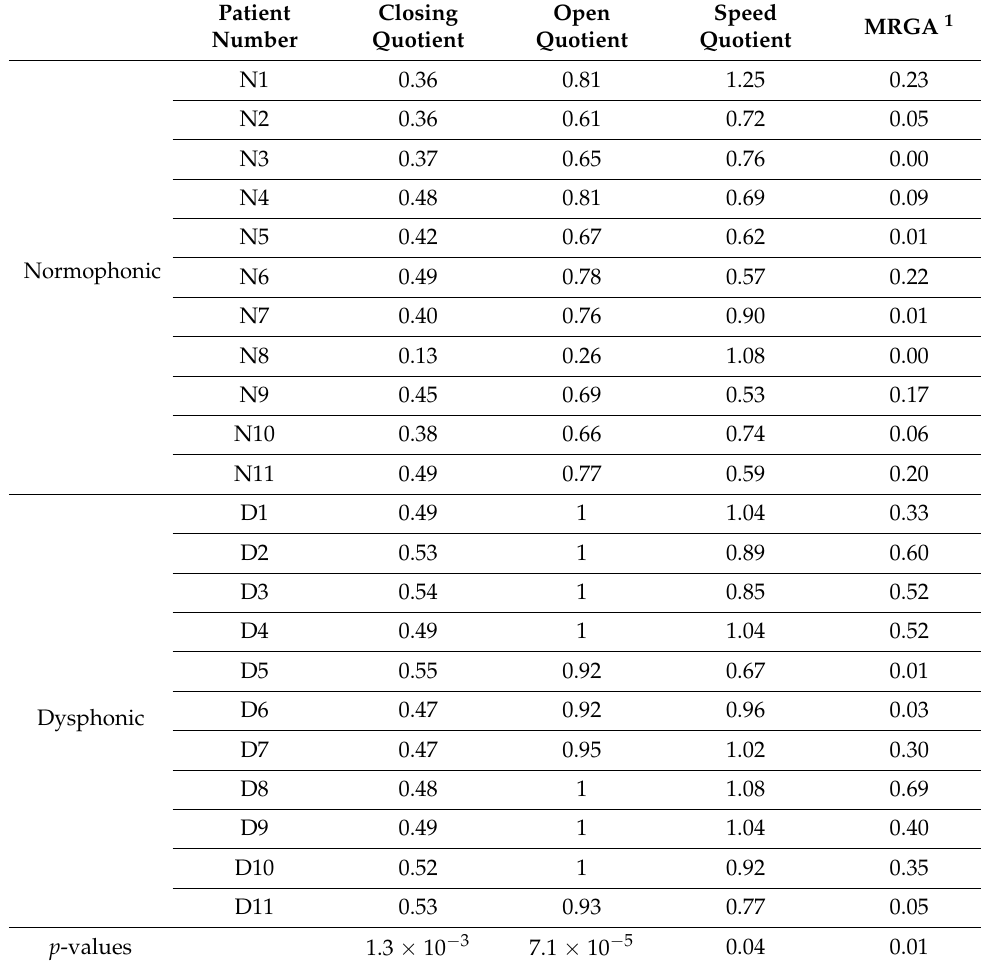
Table 2. Geometric and time-related parameters for the segmented LHSV images in normophonic subjects and dysphonic subjects with glottal insufficiency. Patient Closing Open Speed MRGA 1 Number Quotient Quotient Quotient N1